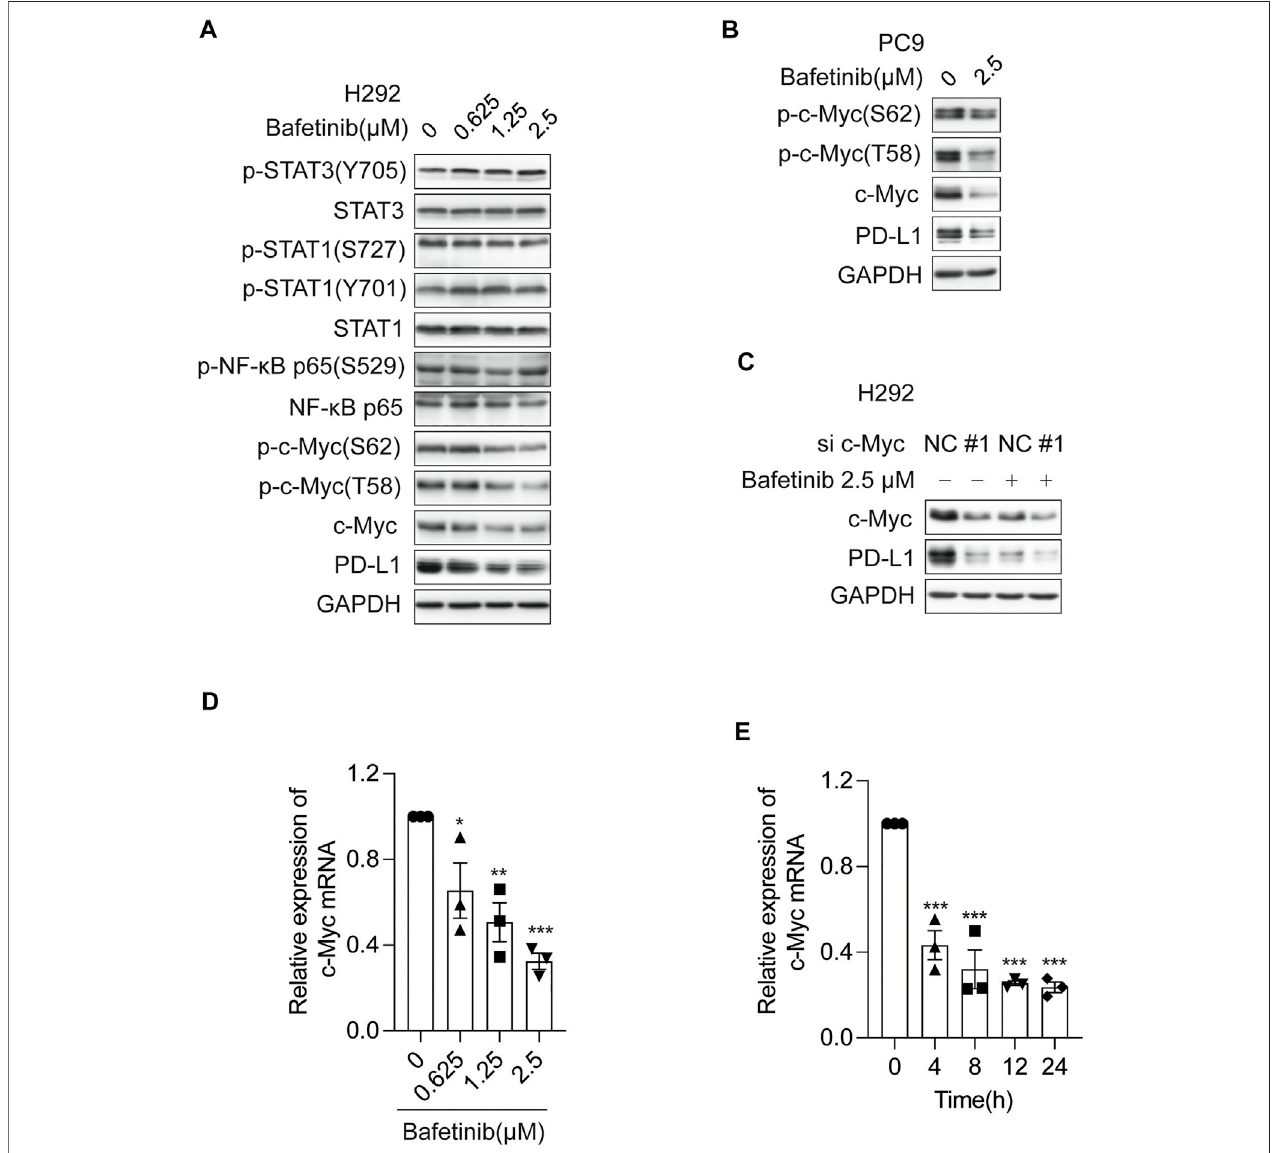
FIGURE 3 | Bafetinib inhibits the expression of PD-L1 by inhibiting the transcription of c-Myc. (A) The expression of p-STAT3 (Y705), STAT3, p-STAT1 (S727), p-STAT1 (Y701), STAT1, p-NF- κ B p65 (S529), NF- κ B p65, p-c-Myc (S62), p-c-Myc (T58), c-Myc and PD-L1 was measured by Western blot in H292 cells after 24 h of Ba fi tinib (0.625, 1.25 and 2.5 μ M) treatment. (B) Western blot of p-c-Myc (S62), p-c-Myc (T58), c-Myc, and PD-L1 protein in PC9 cells with the treatment of Bafetinib (2.5 μ M). (C) The expression of PD-L1 was measured in H292 cells transfected with siRNA-c-Myc (or siRNA-NC) treated with or without Bafetinib (2.5 μ M). (D) H292 cells were treated with Bafetinib (0.625, 1.25, and 2.5 μ M) for 24 h, then the relative expression of c-Myc mRNA was quanti fi ed by qRT-PCR n = 3. (E) H292 cells were treated with Bafetinib (2.5 μ M) for 0, 4, 8, 12, and 24 h, then the relative expression of c-Myc mRNA was quanti fi ed by qRT-PCR n = 3. The data were analyzed by one-way ANOVA with Dunnett ’ s post hoc test. ***, p < 0.001; **, p < 0.01; *, p <